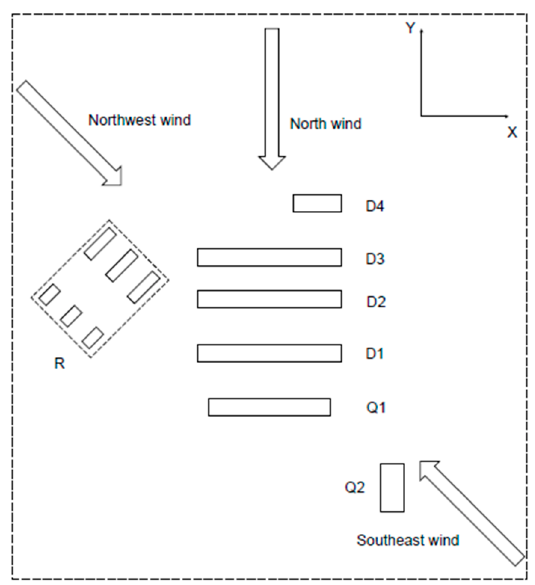
Figure 5. Schematic diagram of dormitory complex under three wind directions. D represents the dormitory building, Q represents the quarantine area, and R represents residential buildings.